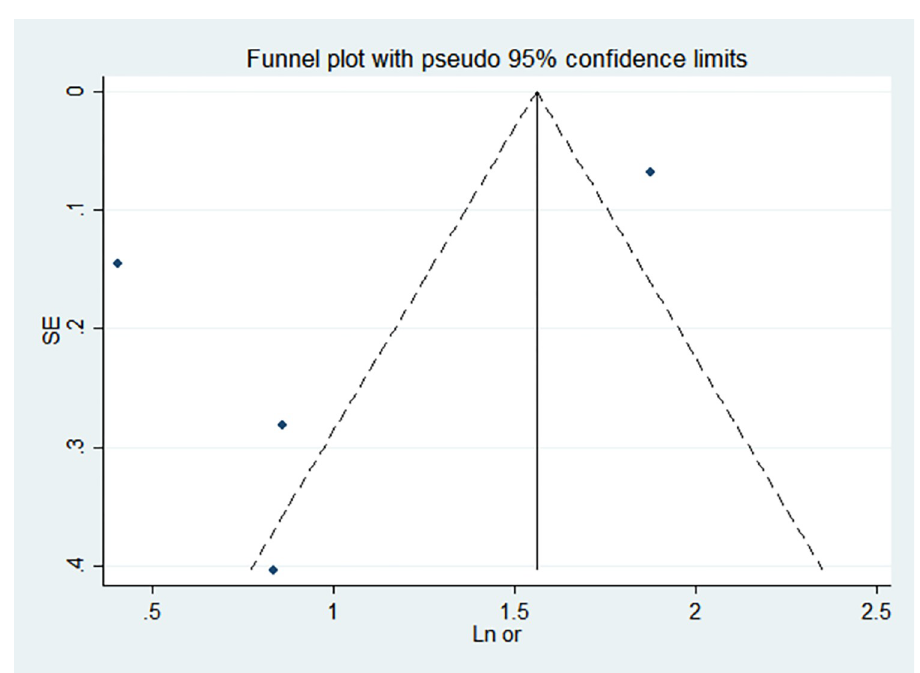
Fig 13. Funnel chart of gestational age < 32